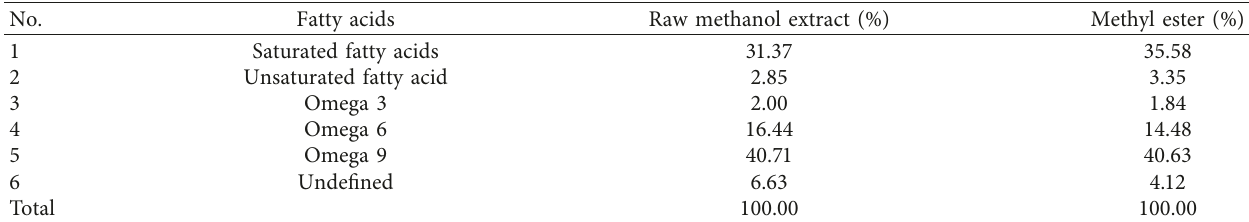
Table 3: The chemical compositions of fatty acids before separation and enrichment by DES.